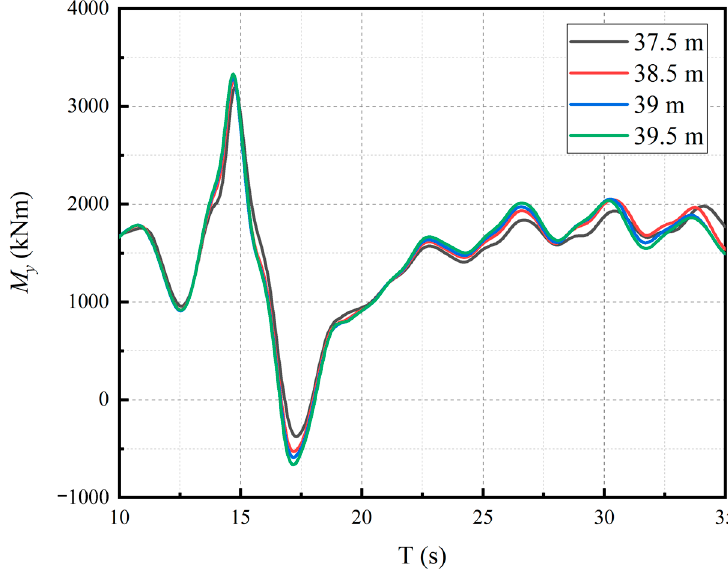
Figure 17. Load time series of M y at blade root.